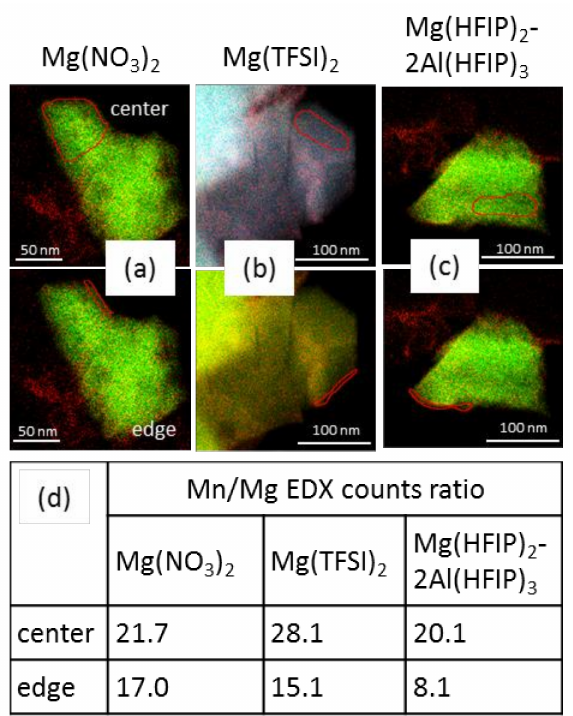
Figure 4. STEM-EDX Mg + Mn maps of a magnesiated manganese spinel cathode material samples cycled for ( a ) 5 cycles in Mg(NO 3 ) 2 , ( b ) 15 cycles until failure in Mg(TFSI) 2 /diglyme, and ( c ) 60 cycles until failure in Mg(HFIP) 2 − 2Al(HFIP) 3 /diglyme; ( d ) table with Mn/Mg counts ratios, calculated from the marked central and edge areas of the particles.